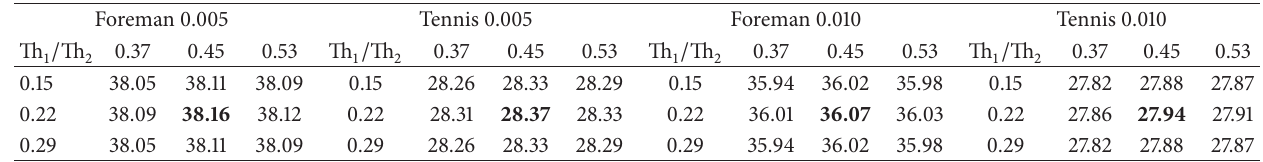
Figure 3: Original frames of the color video sequences: Flowers (20th), Stefan (20th), Foreman (80th), and Tennis (81st). Table 2: PSNR values (dB) for threshold parameters Th 1 / Th 2